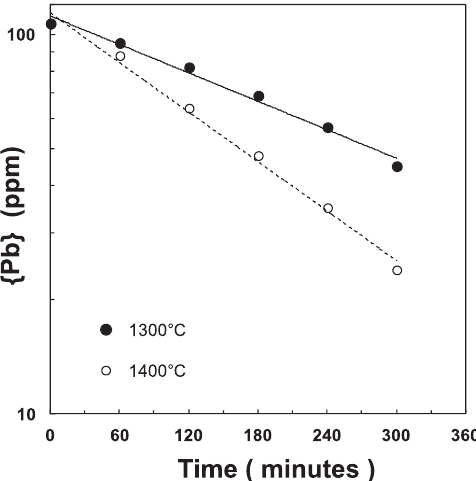
Fig. 4: Comparison of the change in Pb content of a 50% copper matte bubbled with Ar at 100 cm 3 .min − 1 at 1300 °C and 1400 °C.